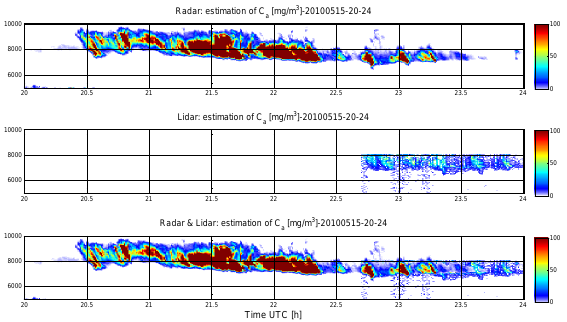
Figure 4: Estimation of ash concentration in the zoomed ash cloud region in Fig. 3, using radar (upper panel), lidar-ceilome- ter (middle panel) and combined lidar-radar observables, when available (lower panel). Figure 6: As in Fig. 4, but for particle mean diameter D n